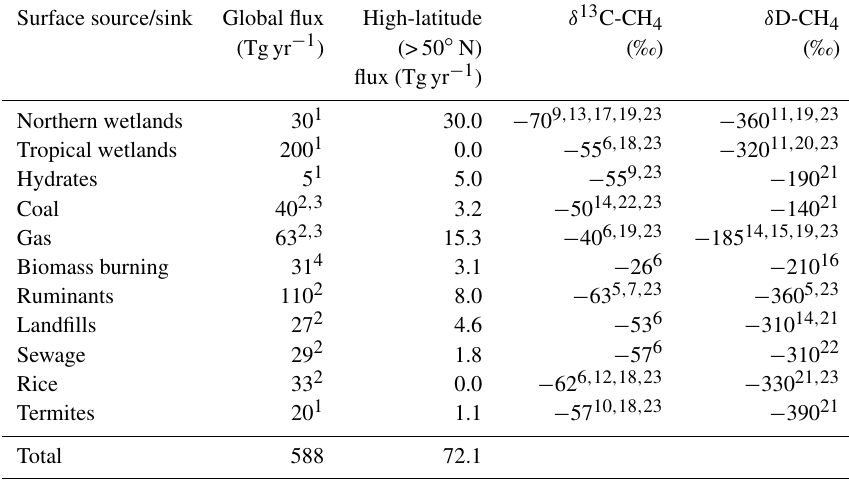
Table 1. Global methane source magnitudes and isotopic signatures used in p-TOMCAT. Surface